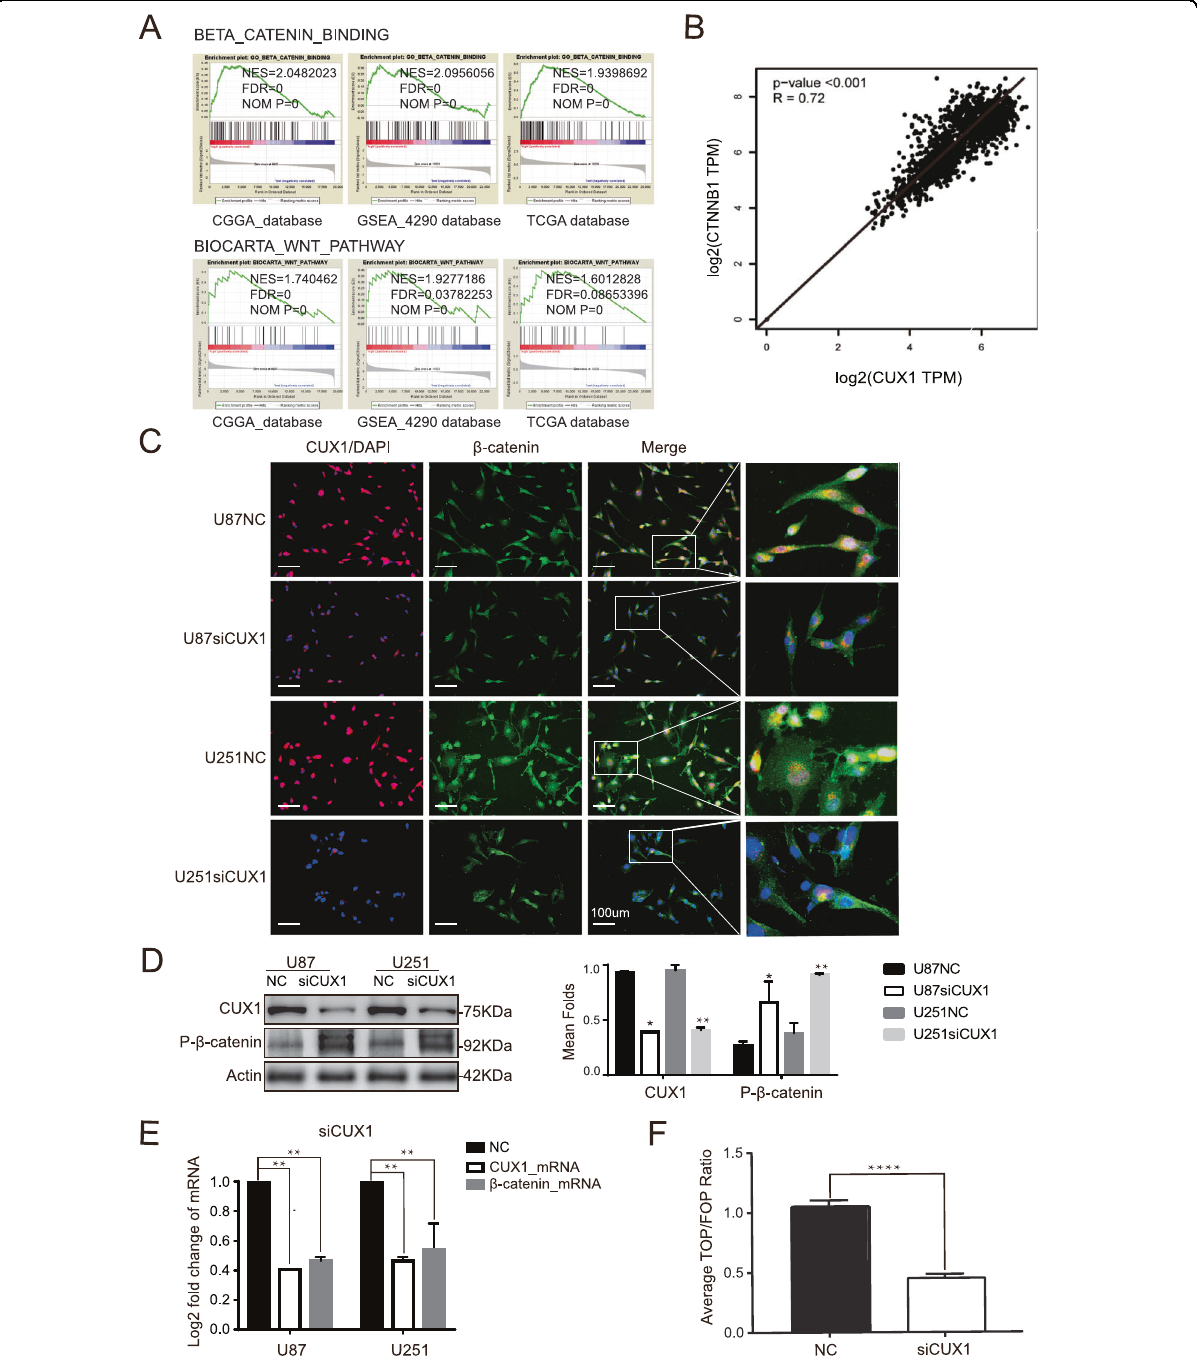
Fig. 4 P75CUX1 regulated β -catenin expression and activated WNT/ β -catenin signaling pathway. a Gene set enrichment analysis (GSEA) showed that there was a signi fi cant correlation between CUX1 mRNA expression and the WNT/ β -catenin pathway in glioma (data from TCGA, CGGA, and GSE4290 databases). b Spearman correlation analysis indicated a signi fi cant correlation between the mRNA expression of CUX1 and β -catenin in glioma and NB tissues ( P < 0.001, R = 0.72, data from TCGA and GTX database). c IF assay revealed that CUX1 knockdown inhibited the total β -catenin expression and β -catenin accumulation in the nucleus of U87 and U251 cells. d WB showed that P- β -catenin (Ser33/37/Thr41) expression increased while P75CUX1 knockdown. e qRT-PCR analysis showed that the CUX1 knockdown reduced the mRNA expression of β -catenin in U87 and U251 cells (** P < 0.01). f TOP/FOP fl ash assay detected that the CUX1 knockdown suppressed the activity of Wnt/ β -catenin in the nucleus. Bars indicated the relative luciferase activity (**** P <